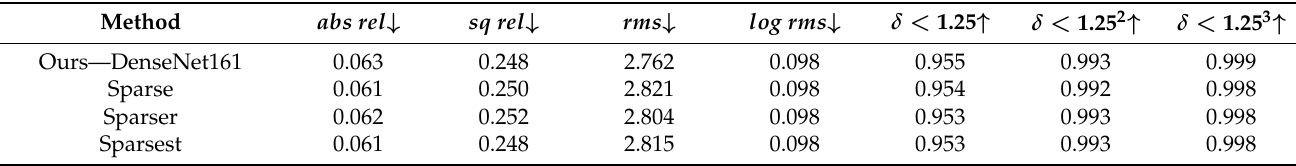
Table 4. Ablation study on the KITTI dataset: performance for different connection densities. All the variants are implemented under DenseNet161 encoder. Metrics indicated by ↓ : lower is better; metrics indicated by ↑ : higher is better.